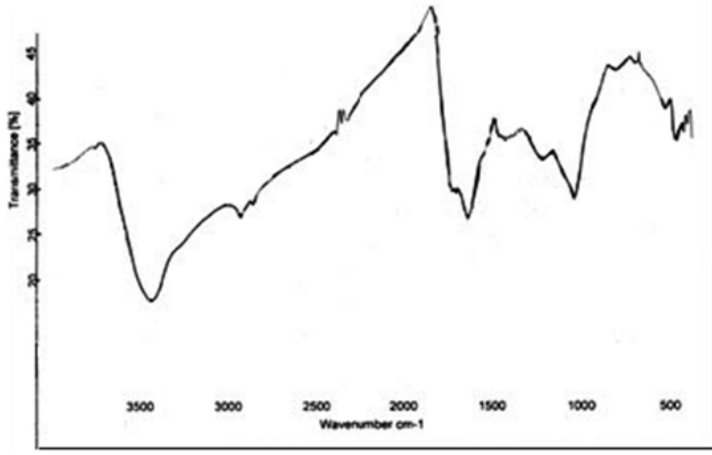
Fig. 1. IR spectra of humic substances isolated from peloid